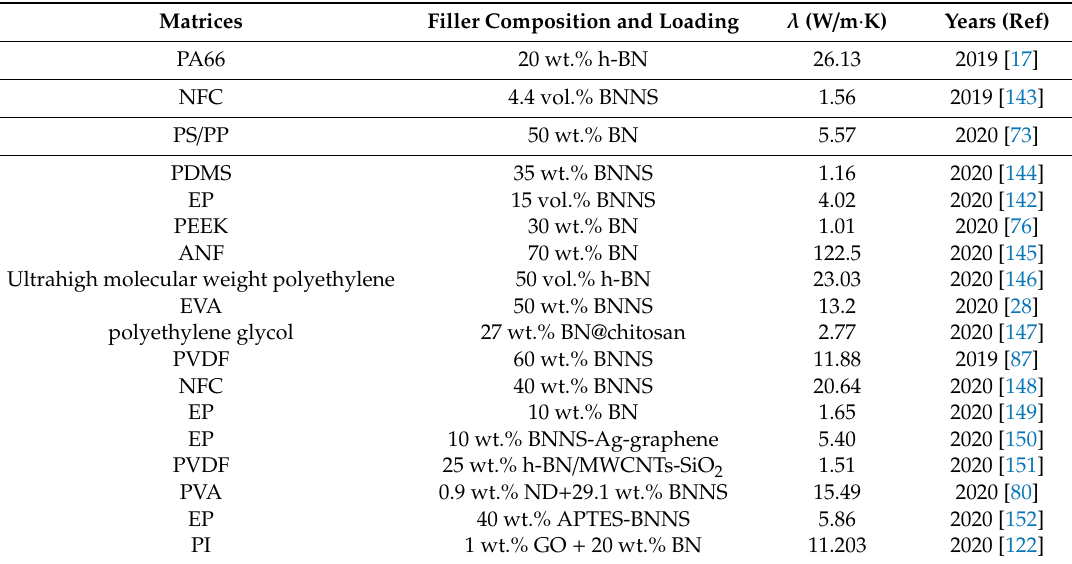
Table 5. λ of boron nitride / polymer